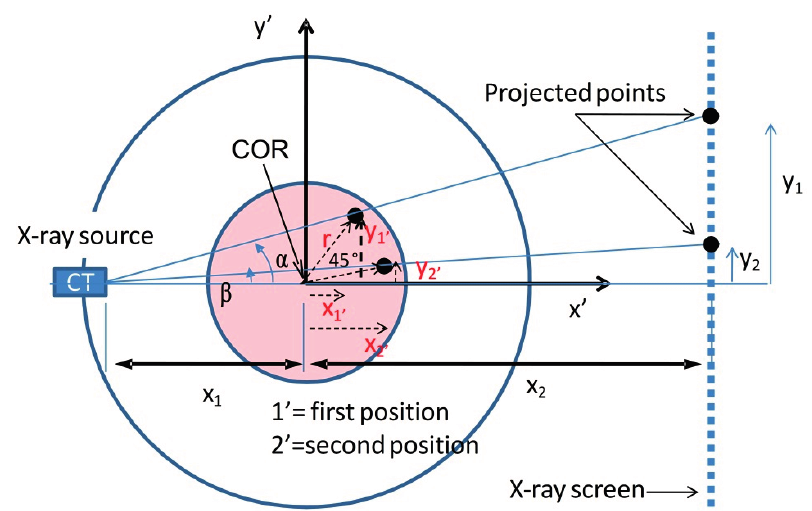
Figure 4. Schematic showing how to determine the position of a point located in the red circle by taking two projections at different orientations. The second one is taken after turning the red circle over